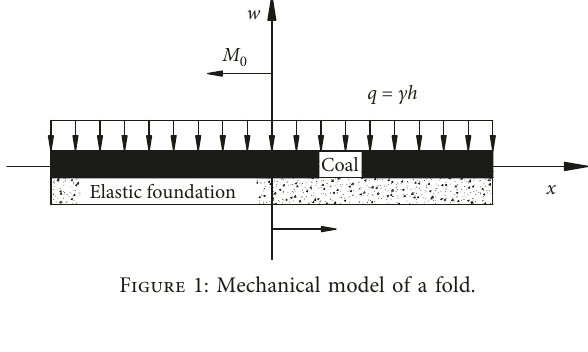
Figure 1: Mechanical model of a fold.